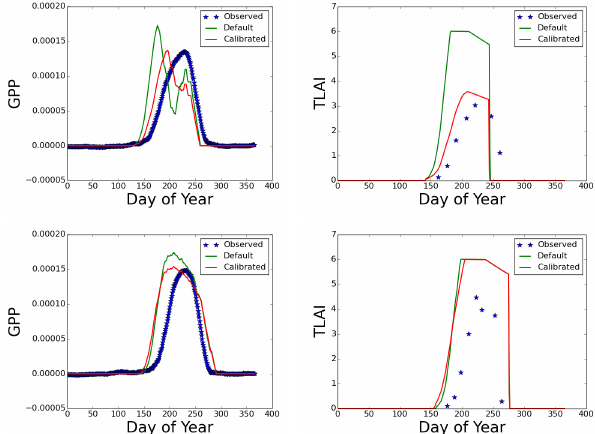
Figure 8. Validation experiment (Mead, NE): comparison of the observed data for 2002 with the model (top). Comparison of the observed data for 2004 with the model